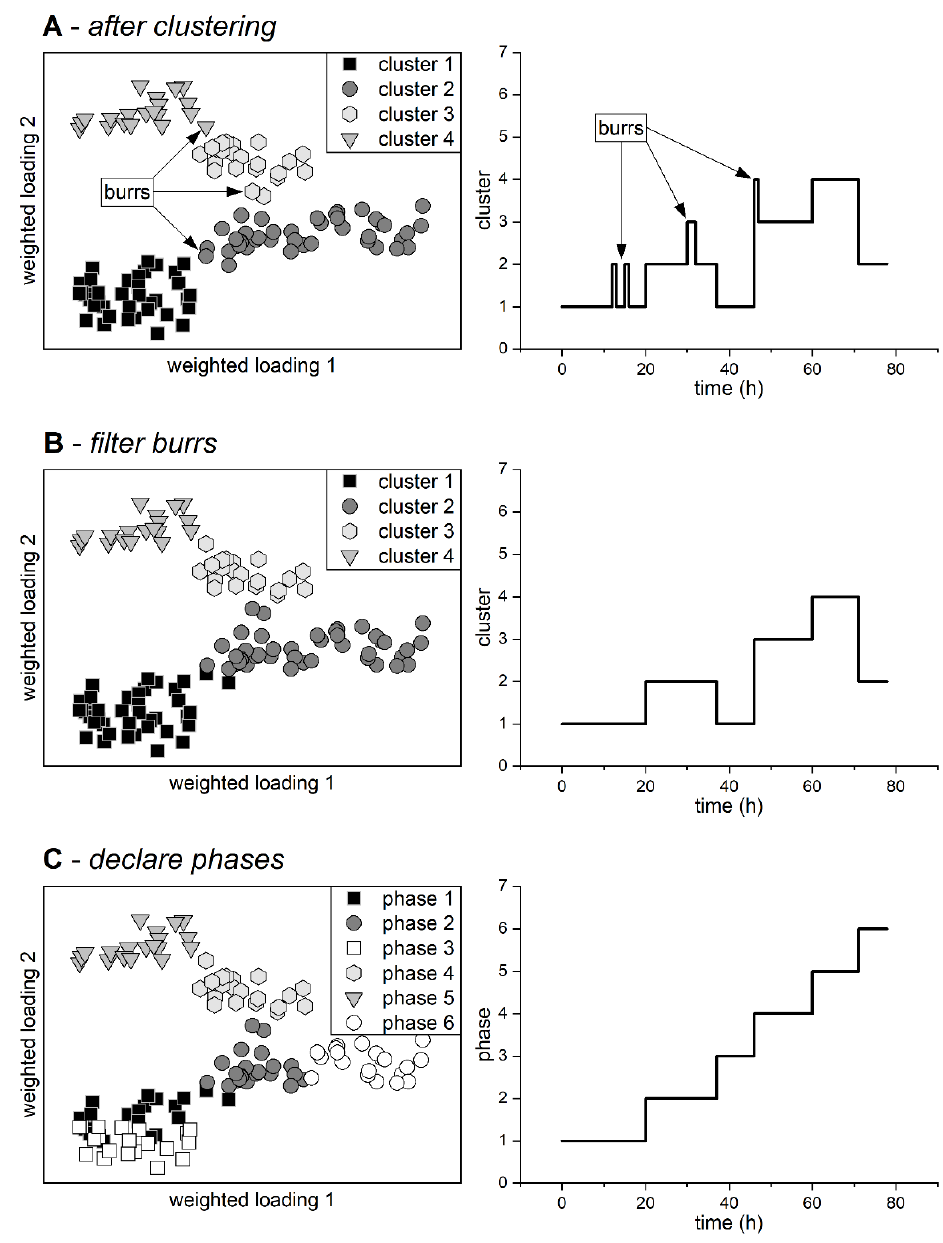
Figure 2. Various stages of generalist phase detection. The clustering of time segments within pro- cesses is shown schematically on the left, based on the weighted loadings of the principal component analysis. Because the actual loadings would represent a high-dimensional space, the representation is schematic. The temporal occurrence of similarity clusters within the selected historical processes is shown on the right. ( A ) Principal component analysis and k -means clustering are used to detect raw similarity clusters. ( B ) The burrs are filtered (outliers in clustering caused by sensor faults). ( C ) Using the clusters’ temporal occurrence to declare